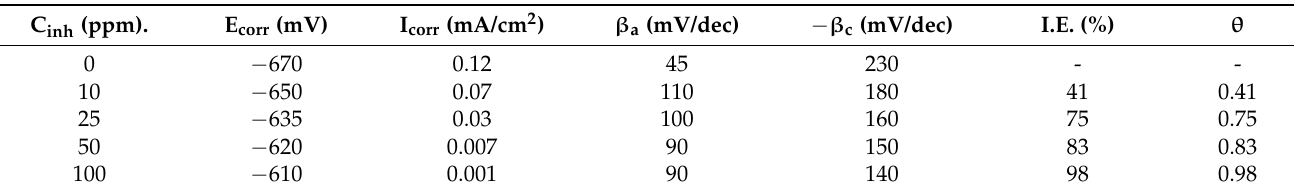
Table 4. Electrochemical parameters obtained from polarization curves for X-120 steel immersed in a CO 2 -saturated NaCl solution containing gemini surfactant.